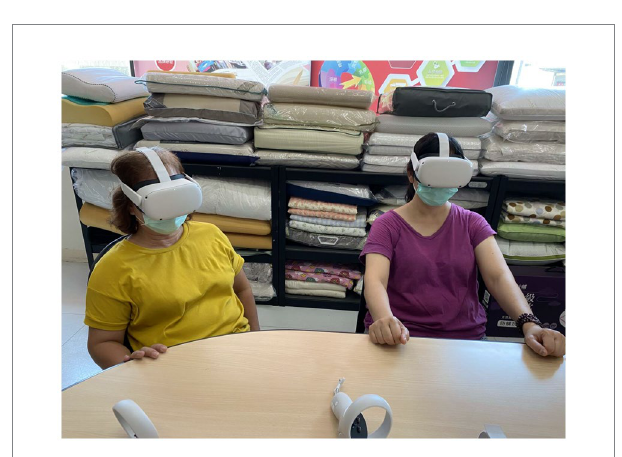
FIGURE 2 Photo of the virtual reality (VR) natural experience